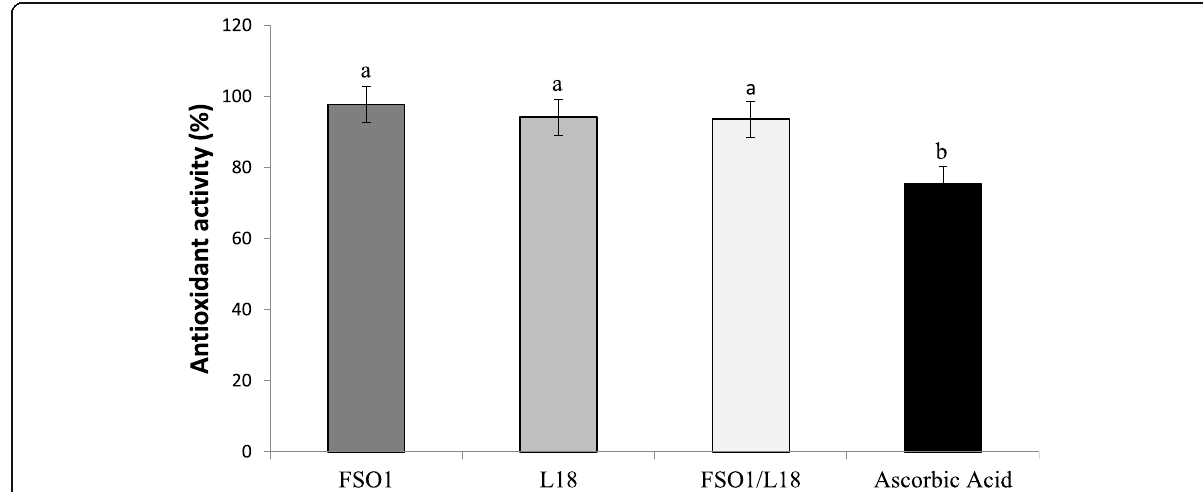
Fig. 5 Free radical scavenging activity (%) of cultures of L. plantarum FSO1, C. pelliculosa L18, and their combination FSO1/L18 obtained after 7 days of incubation at 30 °C in MRSm containing oleuropein as a sole carbon source